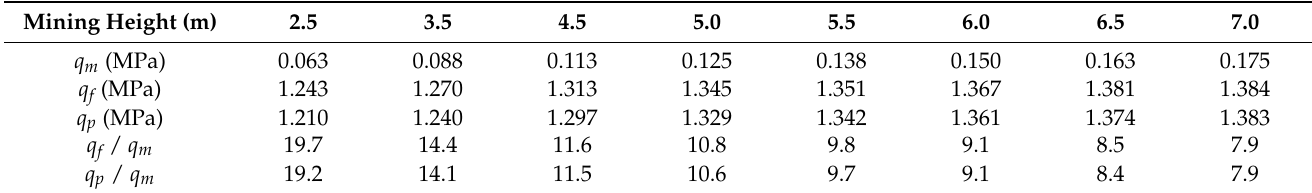
Table 5. Relation between shield resistance and mining